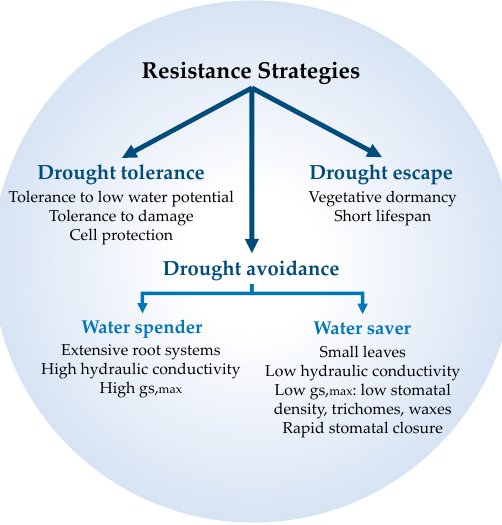
Figure 1. Plant strategies to cope with drought.